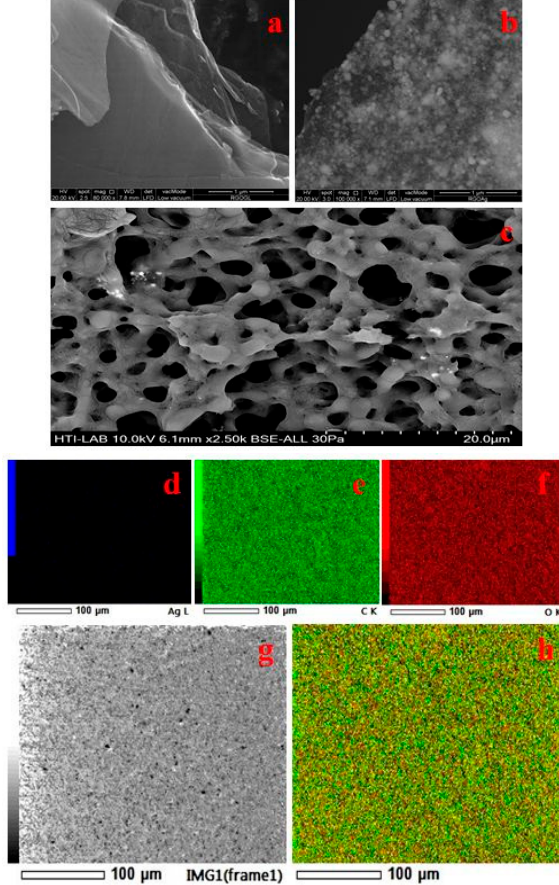
Figure 5. SEM images for the rGO ( a ), Gag ( b ), and PHA/GAg electrospun mats ( c ). Elemental mapping of a sample PHA/GAg scaffold is shown in figure ( d – h ) respectively.